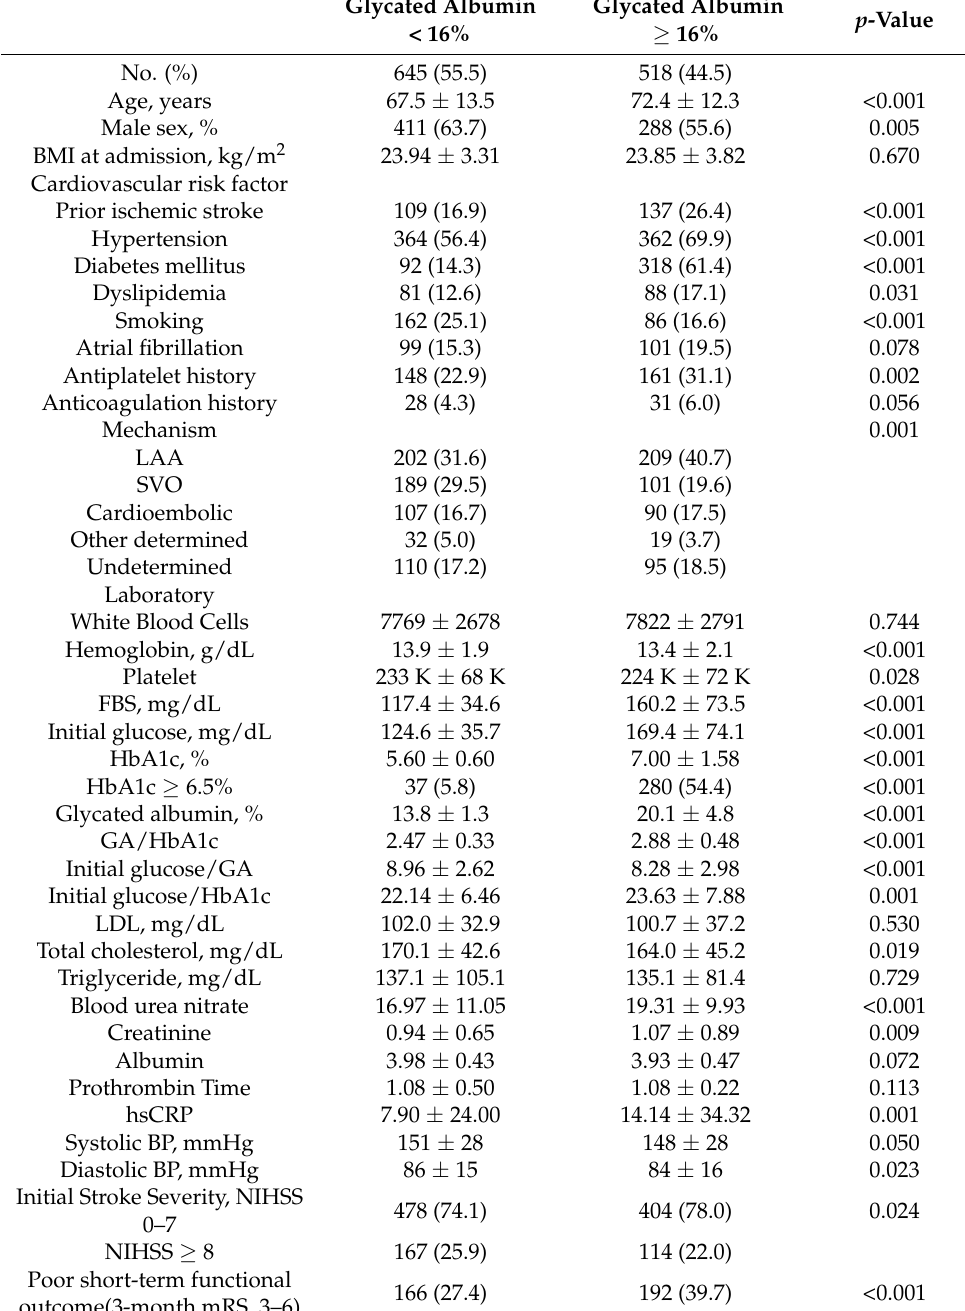
Table 1. Baseline characteristics according to levels of glycated